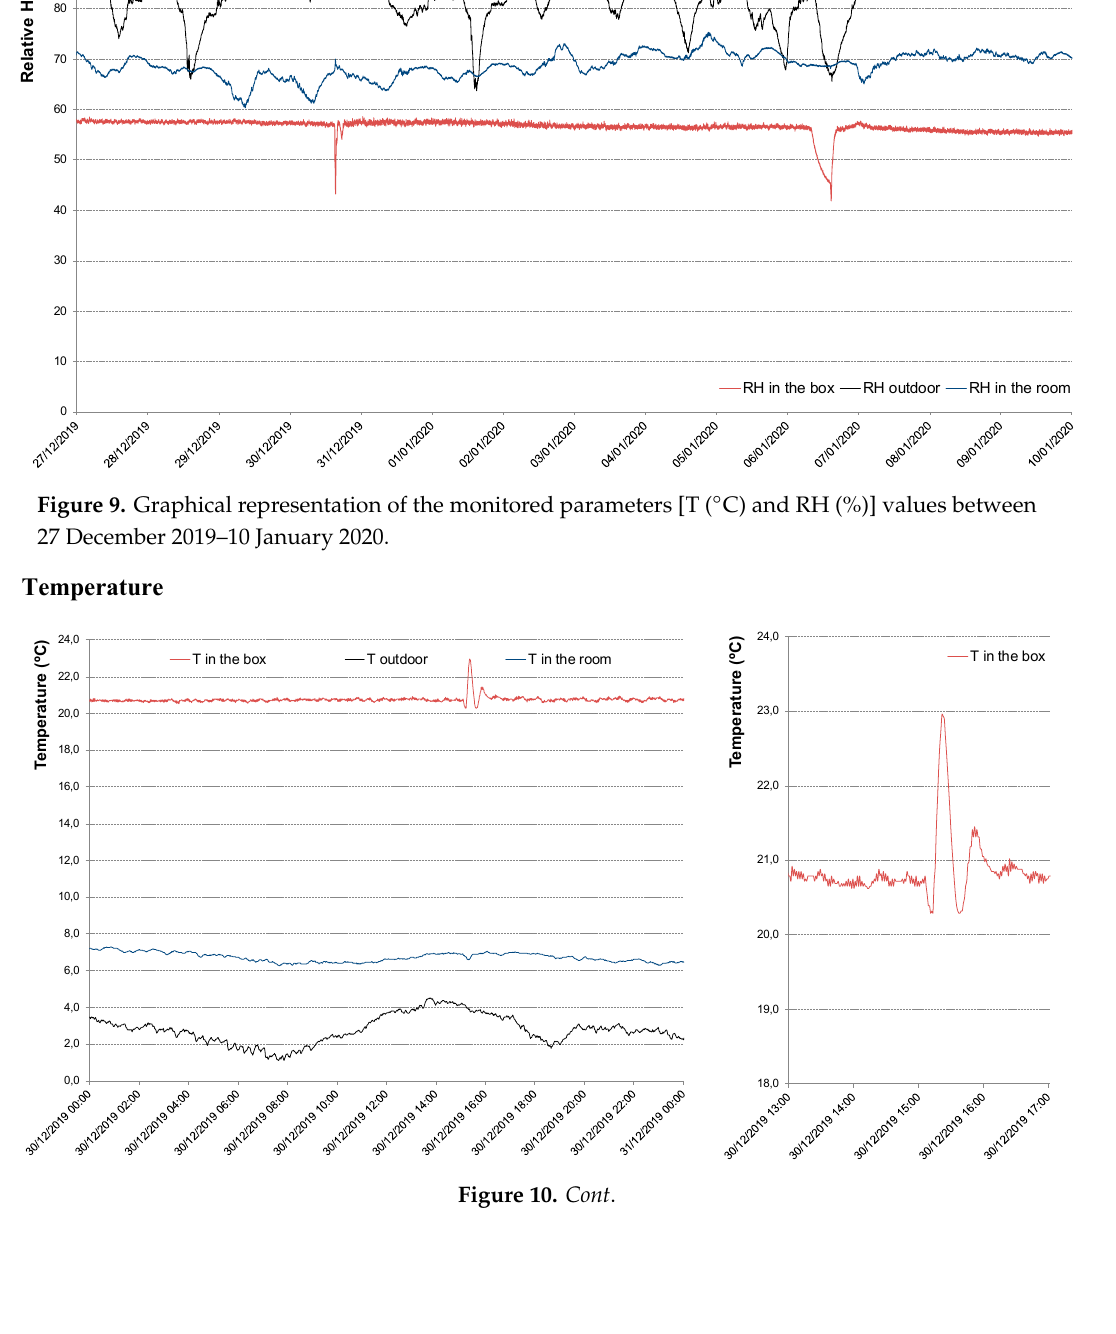
Figure 9. Graphical representation of the monitored parameters [T (°C) and RH (%)] values between